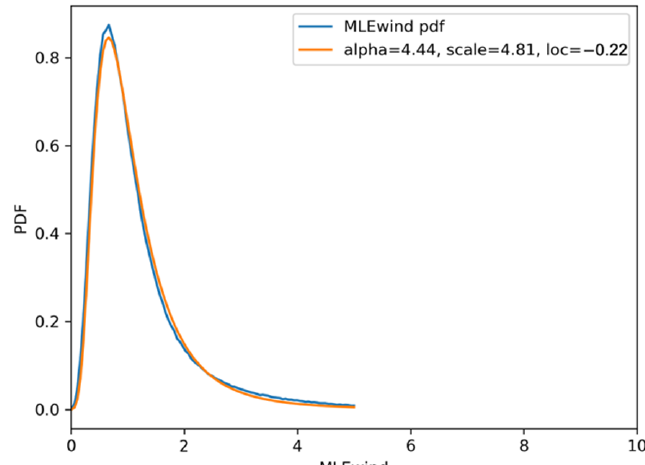
Figure 1. Probability distribution of MLE wind (normalized to unit area): blue is the observed p ( MLE wind ) , orange is the fitted probability function derived from an inverse gamma distribution as in Equation (6).